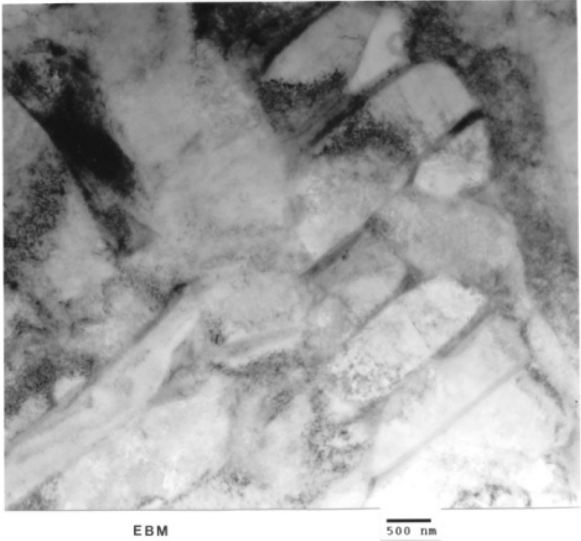
Figure 10. TEM of EBM showing α -phase in Ti-6Al-4V. Dark areas separating α -phase grains is β .